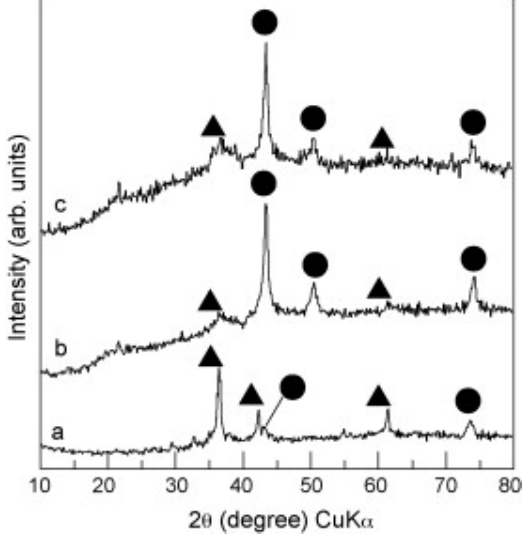
Figure 3. XRD patterns of ( a ) uncoated Cu NPs; ( b ) Cu/SiO month after preparation. (●) Metallic Cu, ( ) Cu permission from